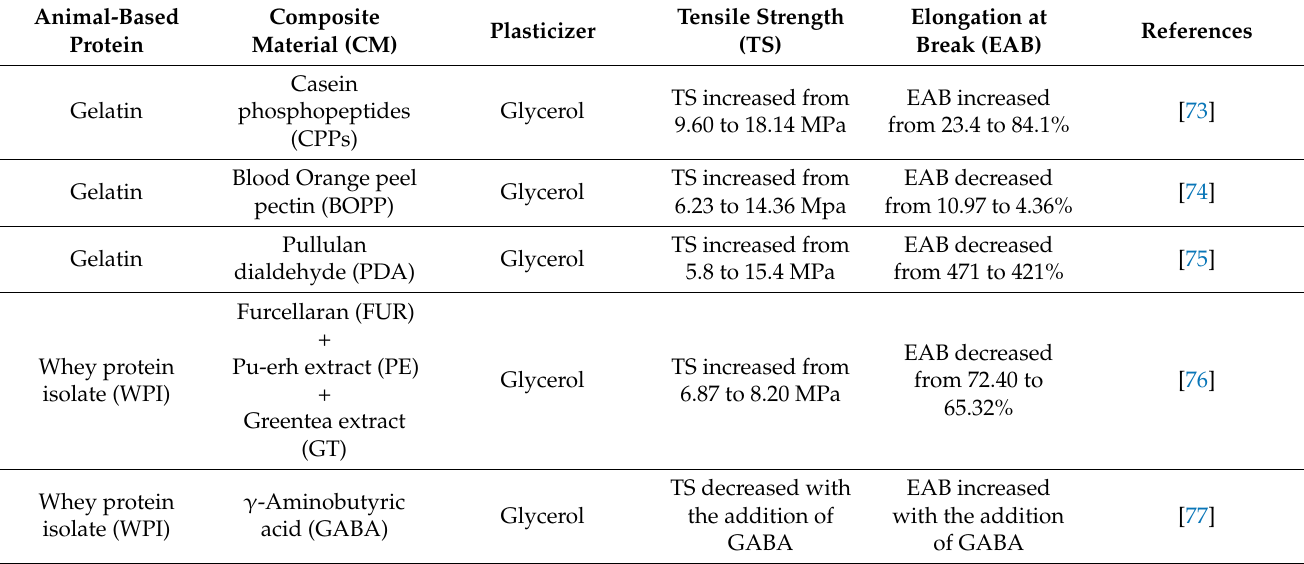
Table 3. Mechanical properties of edible films based on animal